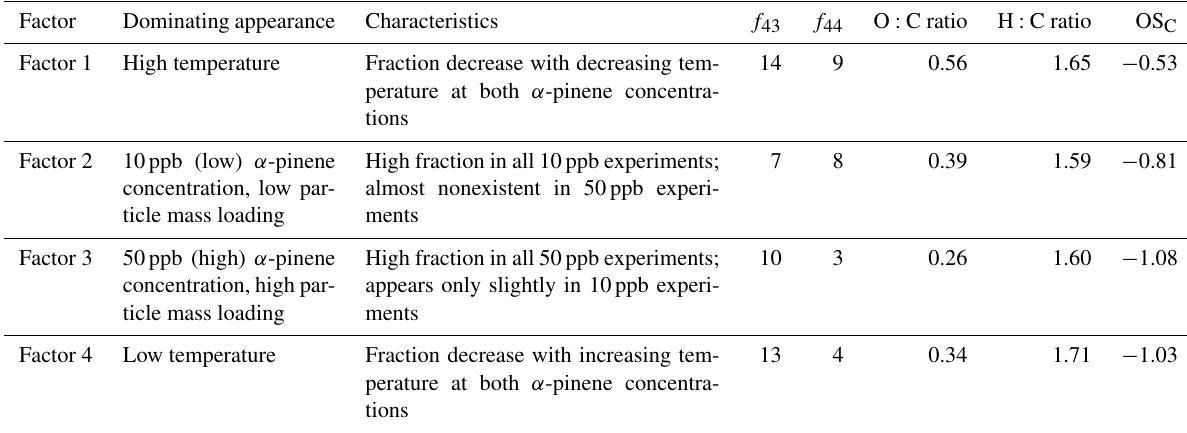
Table 2. Characteristics of the four factors obtained from PMF analysis of experiments (1.1, 1.2, 1.3, 1.4, 1.5, 3.1, 3.2, and 3.3) according to Fig. 2. For each factor, the fraction of m/z 43 ( f 43 ) and m/z 44 ( f 44 ) relative to the total mass spectra is given as a percentage.